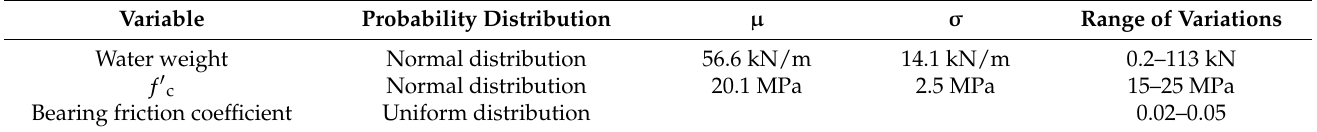
Table 2. Variable distribution of the sampling results.